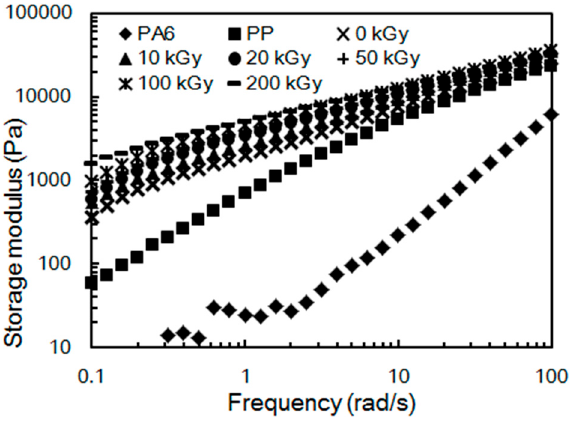
Figure 5. Storage moduli of PA6/PP (80/20) blends irradiated at different dosages as a function of frequency at 235 °C.